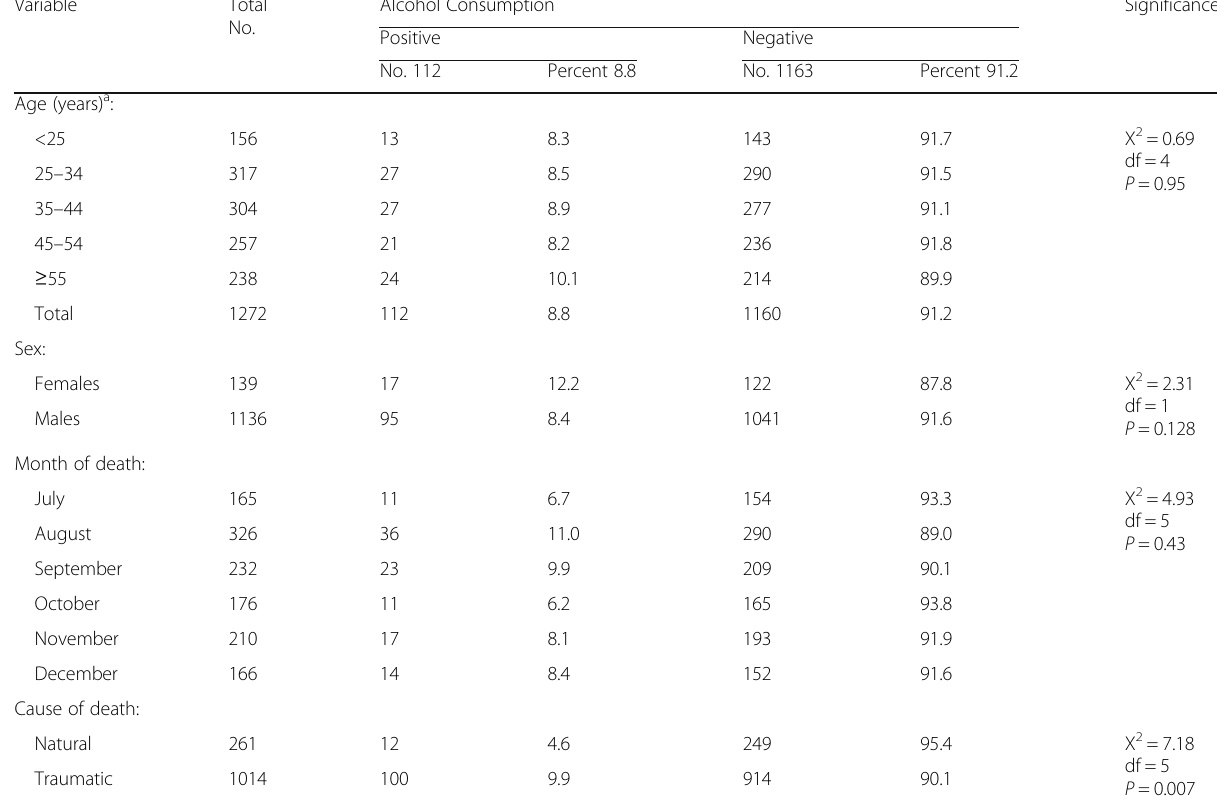
Table 2 Relation of alcohol consumption with the studied variables Variable Total